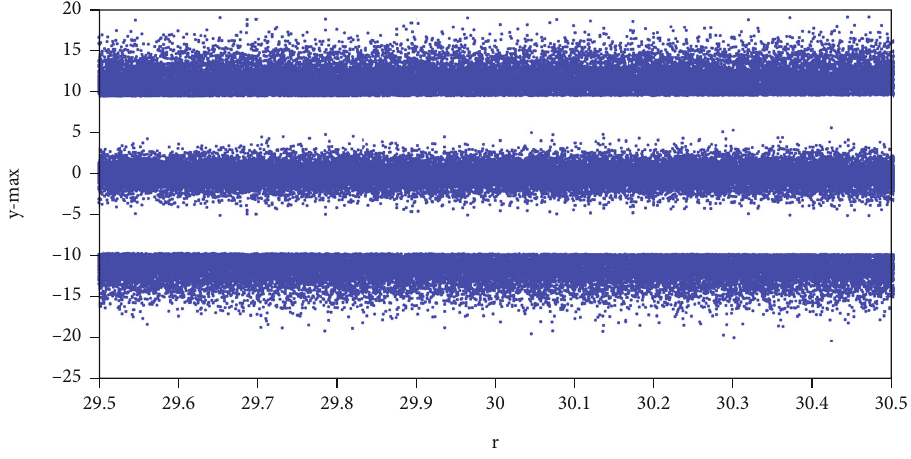
Figure 6: Bifurcation diagram for r ∈ ½ 29 : 5,30 : 5 (cid:2) and η = 0 : 974